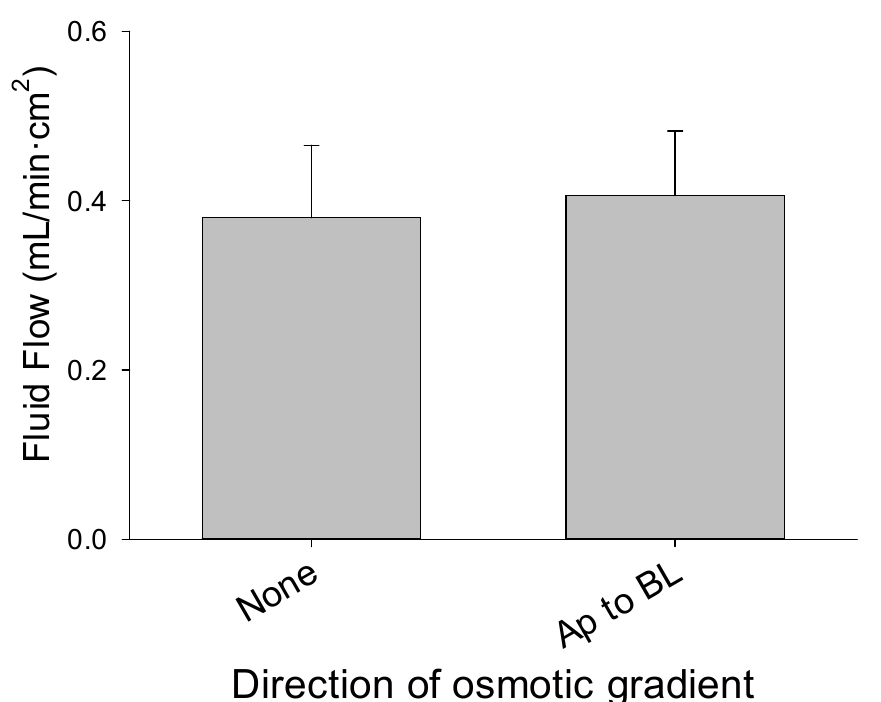
Figure 9. Basolateral-to-apical fluid flow by cultured enterocytes did not differ when measured with 290 mosmol normal Ringer’s solution in both chambers and when the Ringer’s solution in the apical chamber was diluted to 200 mosmol to create an apical-to-basolateral osmotic gradient ( n = 4 inserts per condition).